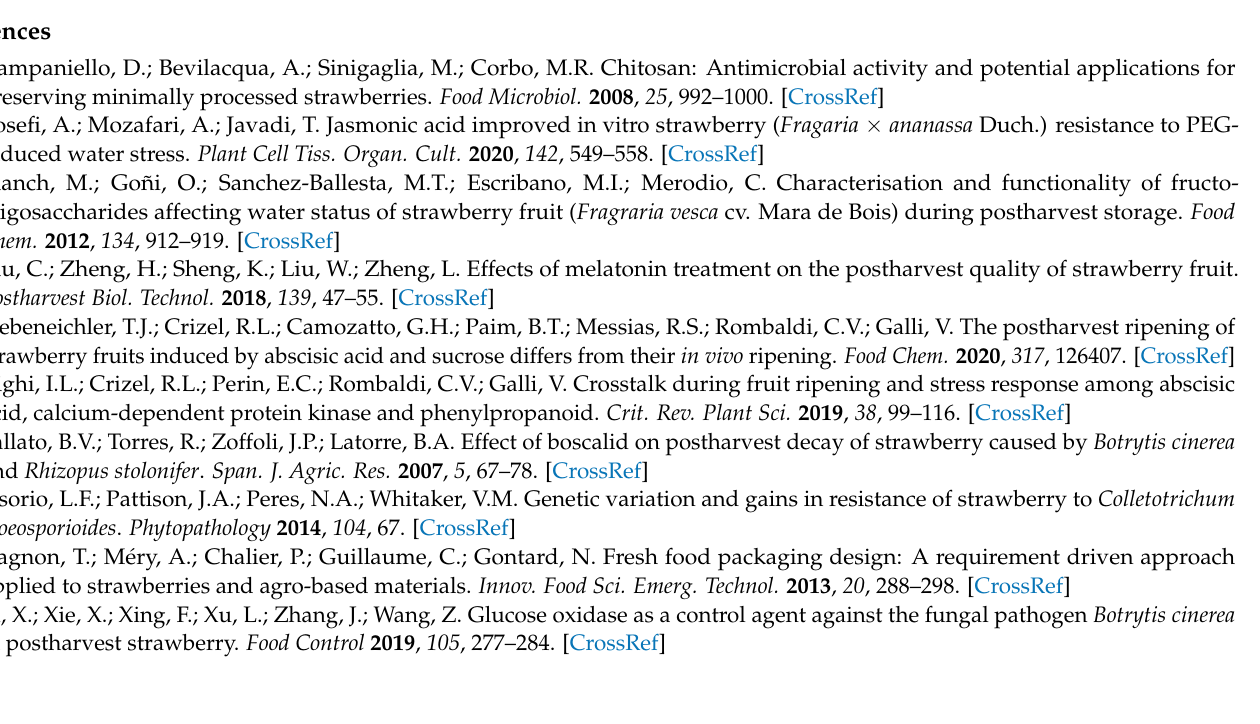
Table S2: Primers used for gene expression analysis by